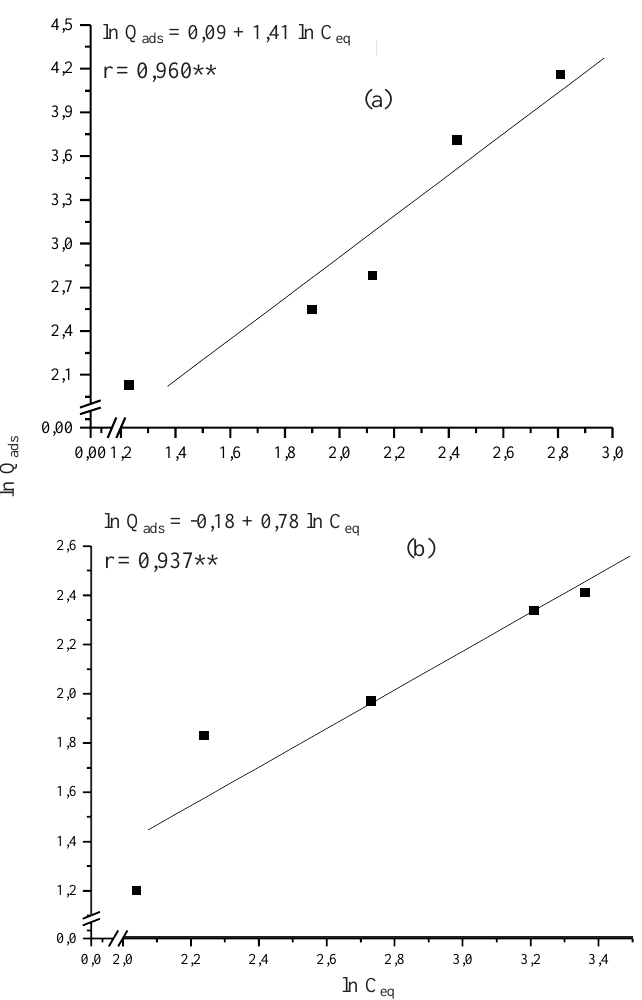
Figura 2. Isoterma de sorção de atrazina em Cambissolo Húmico na forma natural (a) e oxidada (b). : quantidade de atrazina sorvida, mg kg -1 ; C Q ads P <